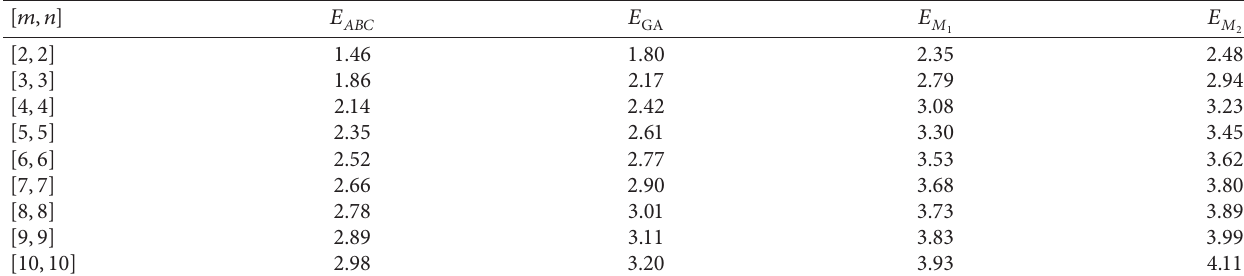
E , E M , and E M ABC , GA 1